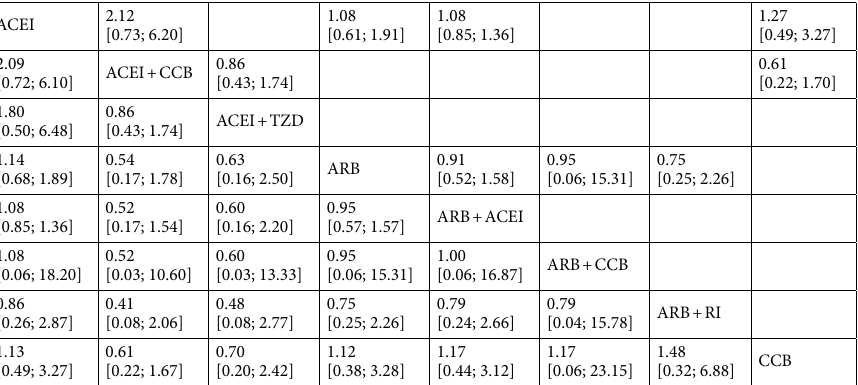
Table 6. Net league table of ESRD progression. ACEI, angiotensin converting enzyme inhibitors; ARB, angiotensin receptor blockers; CCB, calcium channel blockers; ESRD, end stage renal disease; RI, renin inhibitor; TZD, thiazide diuretics.